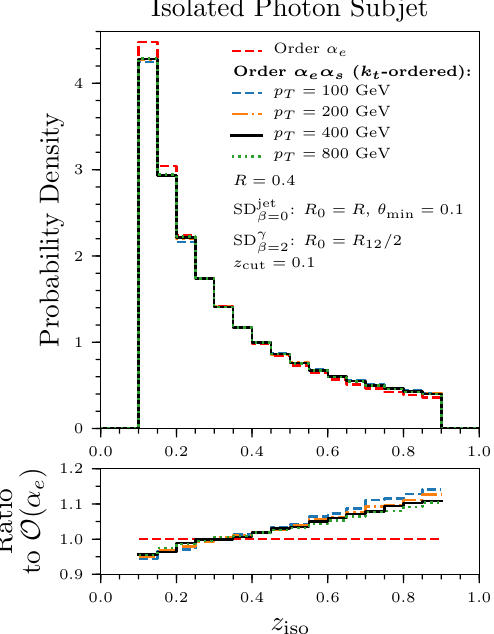
Figure 5. Probability densities for isolated photon subjet momentum fraction z order (cid:11) e (cid:11) s in the collinear limit. Shown are results at p T = for (cid:12)nding isolated photon subjets is so small, we turn o(cid:11) ISR and underlying event